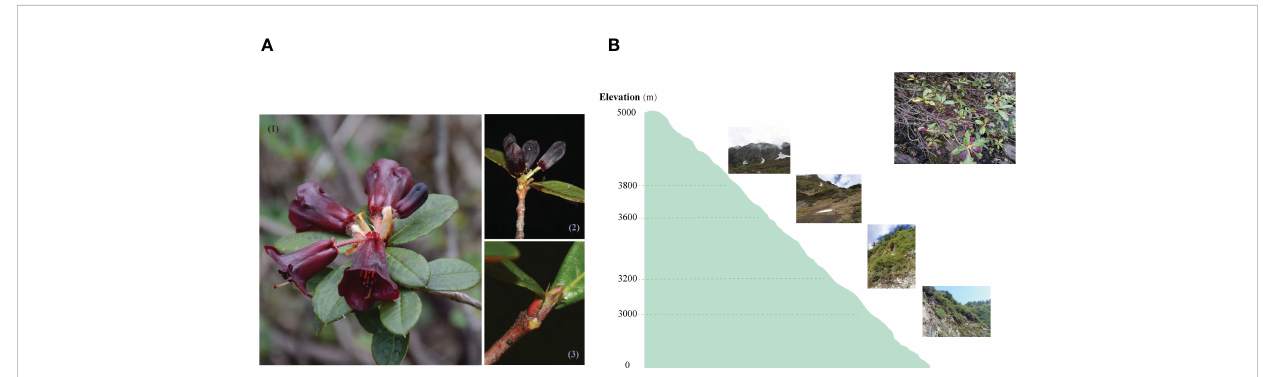
FIGURE 1 Morphological characters, sampling organs (A) , schematic sampling map and wild habitats (B) of R . sanguineum var. haemaleum . Morphology of open fl owers and fully expaned leaves (1), sampled stage for entire late fl ower buds (2), and entire early leaf buds